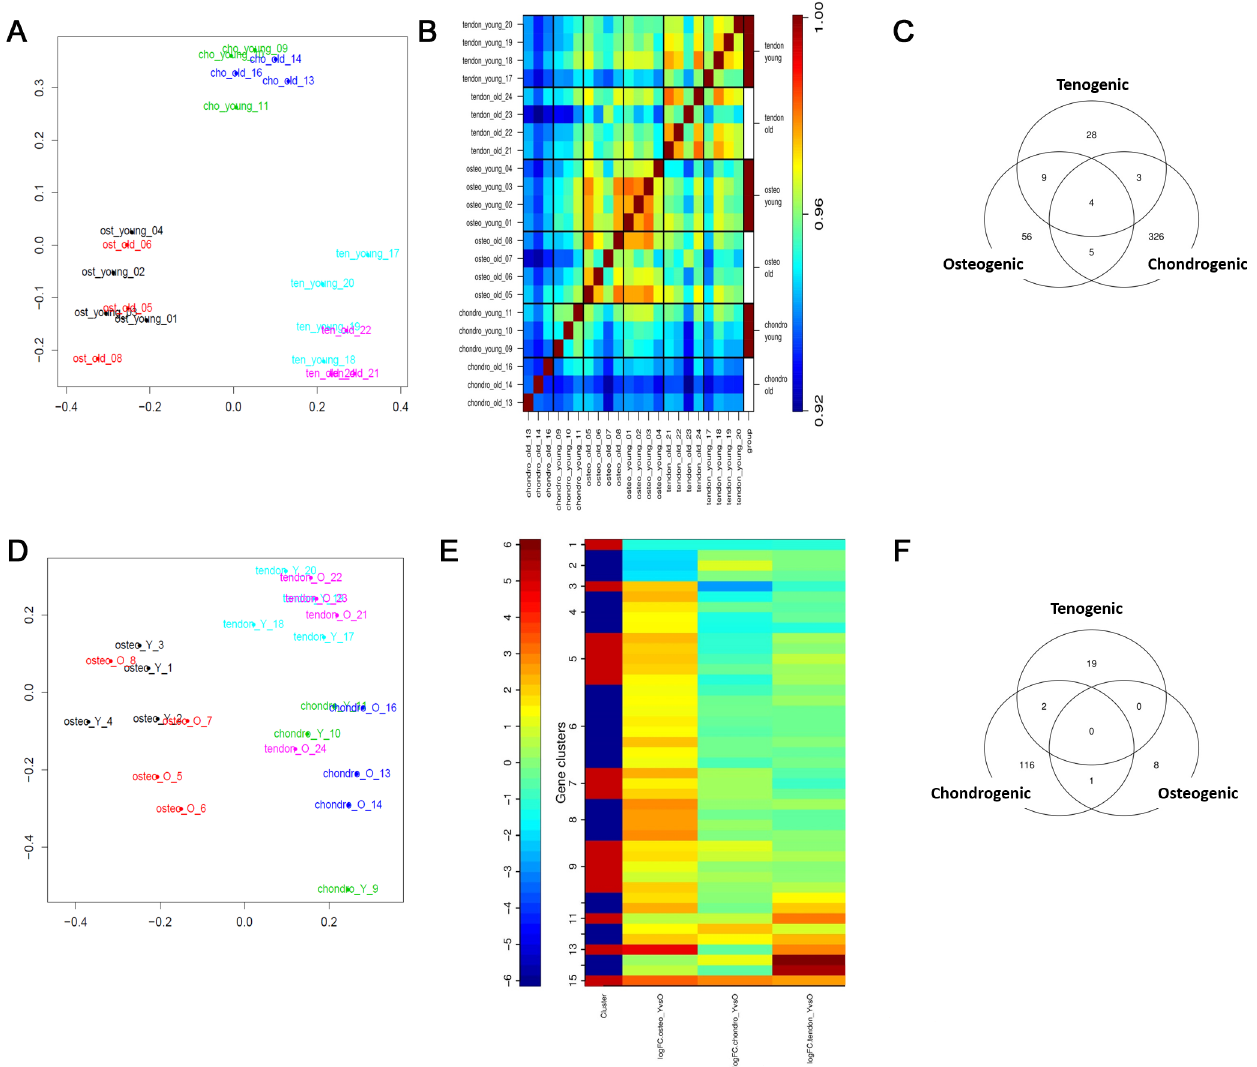
Fig 2. (A) A PCA plot of RNASeq data revealed the greatest variability in RNASeq data was tissue type. (B) Correlation heatmap of RNASeq data from chondrogenic (chondro), osteogenic (osteo) and tenogenic (tendon) engineered tissues derived from young and old MSCs. Samples from same tissue are more closely correlated than sample from different tissue. (C) Venn diagram showing the DE genes from RNASeq for chondrogenic, osteogenic tenogenic engineered tissues (D) PCA plot of small RNASeq data. (E) Correlation heatmap of age-related DE